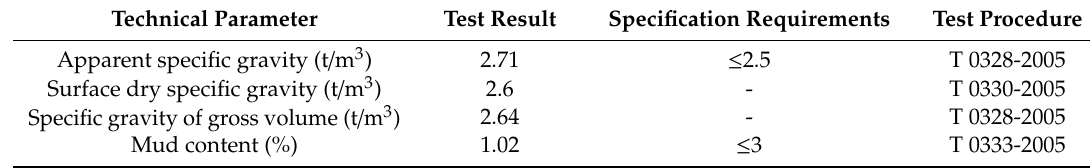
Table 3. Technical parameters of fine aggregate.